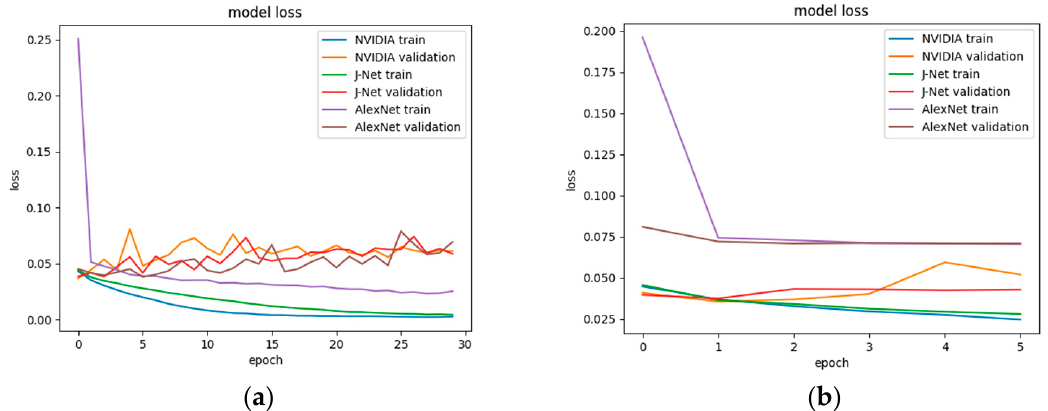
Figure 15. Model loss for training and validation for AlexNet, PilotNet (i.e., NVIDIA CNN—Convolutional Neural Network by NVIDIA Corporation), and J-Net ( a ) for training in 30 epochs; ( b ) for training in 6